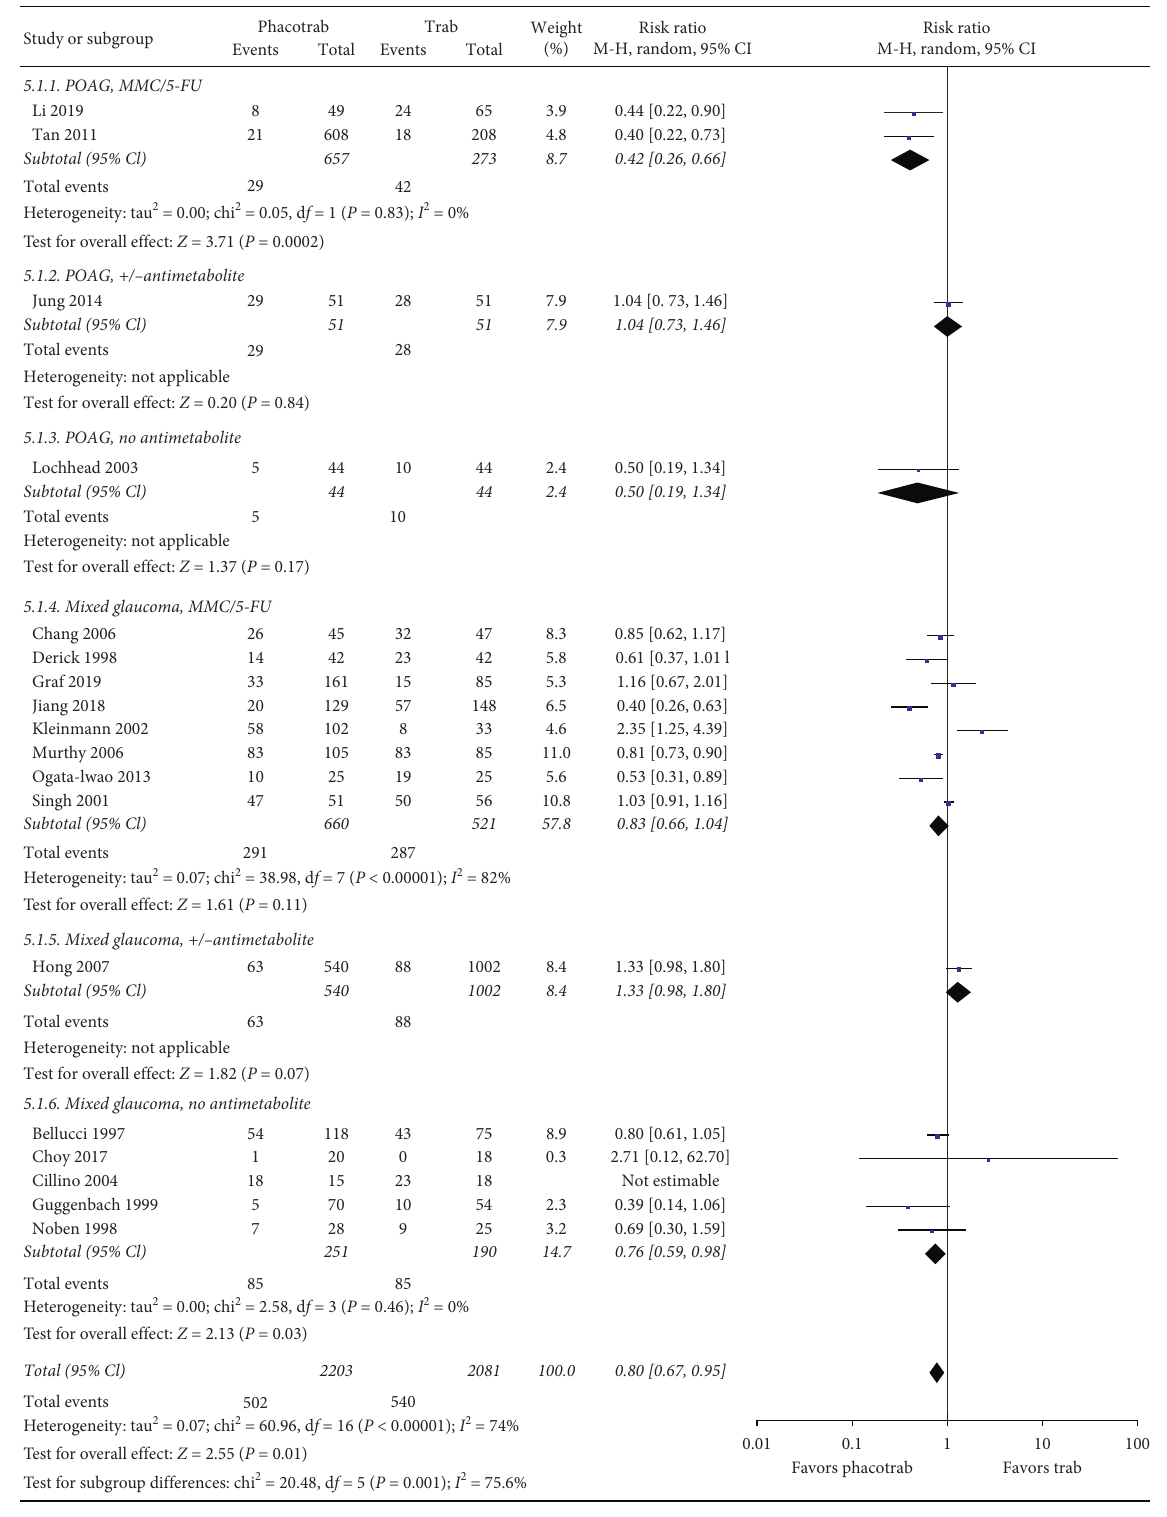
Figure 5: Forest plot of the risk of complications after phacotrabeculectomy versus trabeculectomy only. CI � confidence interval; d f � degrees of freedom; IV � inverse variance; SD � standard deviation. MMC � mitomycin c; 5-FU � 5-fluorouracil; ± antimetabolite � not all eyes received